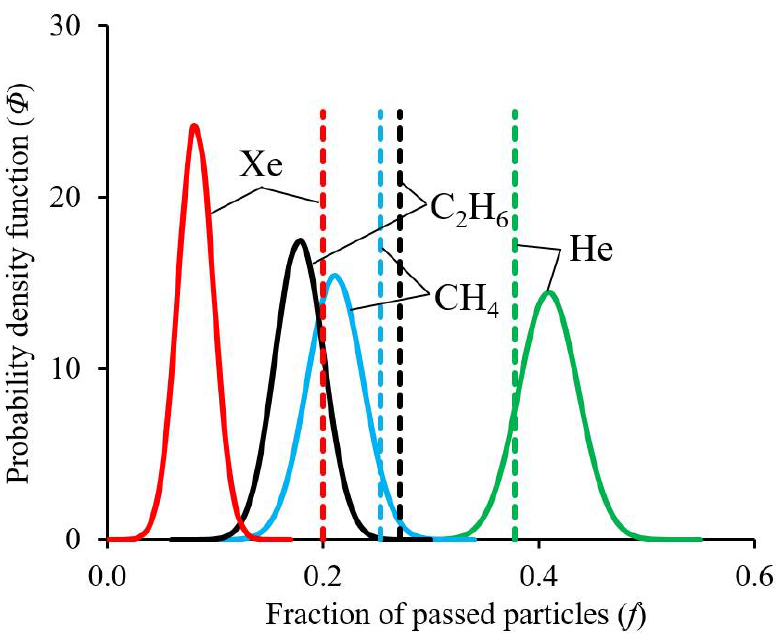
Figure 6. Probability density functions for particles moving with thermal velocity (13) corresponding to a temperature of 260 K. Table 1. Lennard-Jones parameters for the mixture (particle-carbon) and particle mass.